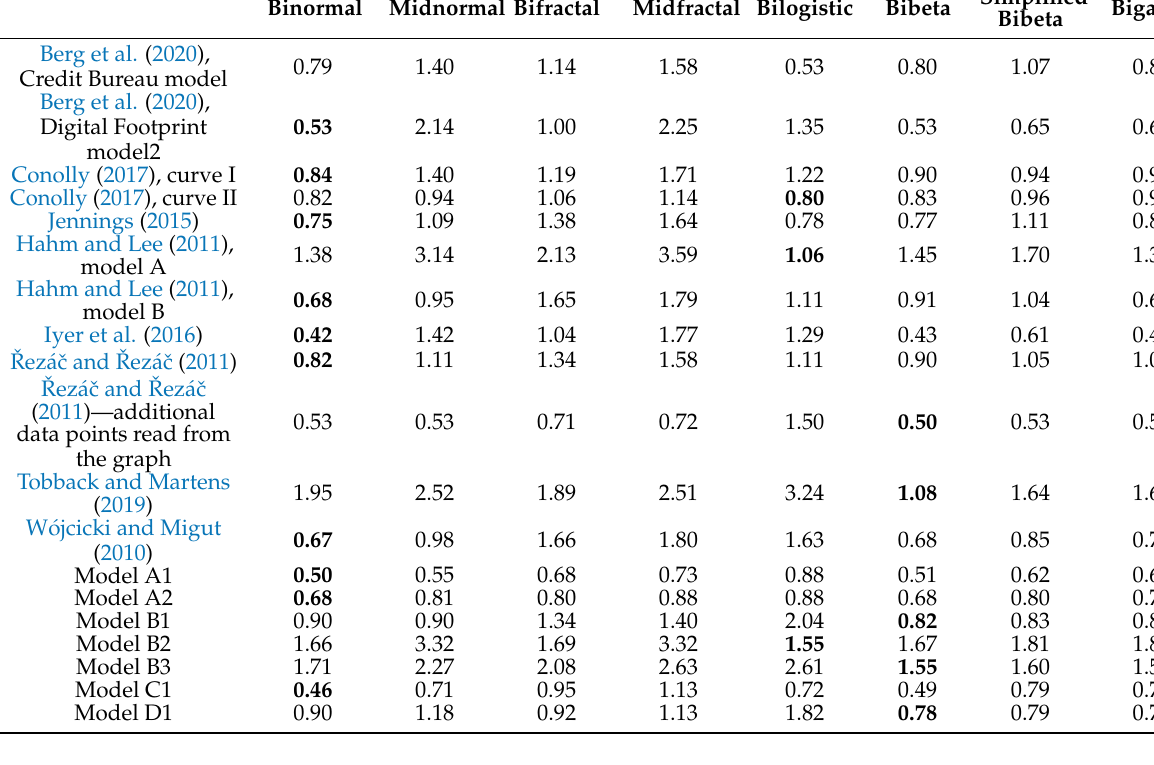
Table 2. ROC model curve fitting—the goodness of fit ( (cid:3493)𝑓 (cid:3042)(cid:3029)(cid:3037) × 100 ).